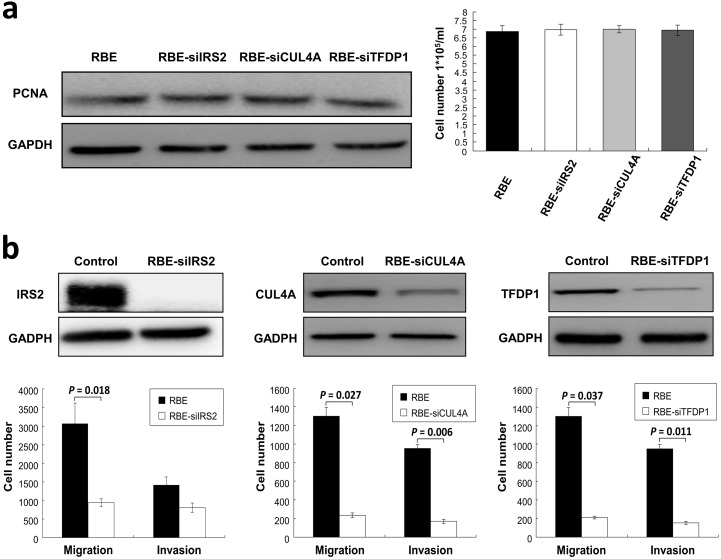
Silencing of IRS2, CUL4A and TFDP1 in iCCA cells.(a) RBE cells were transiently transfected with siRNAs (RBE-siIRS2, RBE-siCUL4A and RBE-siTFDP1). The effect of gene expression after manipulation on growth potential was determined by Western blotting using anti-PCNA antibody (left) and manual counting of total cell numbers (right). (b) Silencing of the target genes, which were confirmed by Western blotting, dramatically reduced the mobility potential of RBE cells. Data represent means ± standard deviations for three independent experiments.